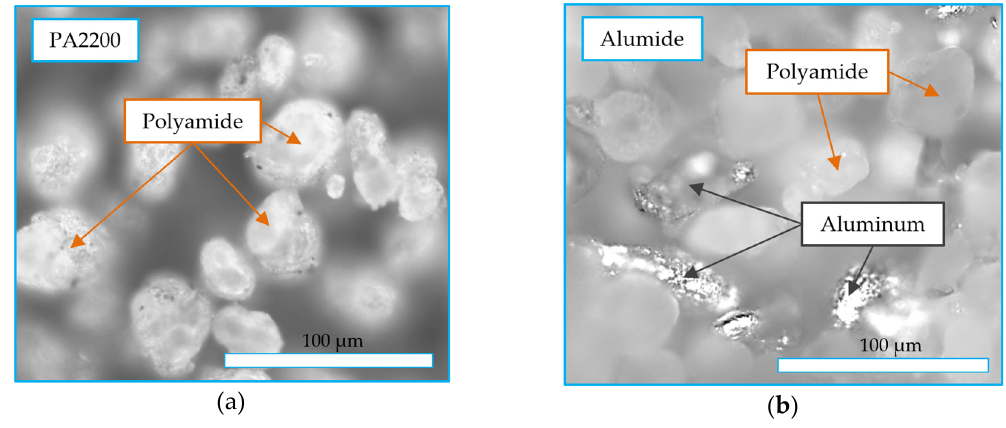
Figure 9. Structure of polyamide ( a ) and Alumide ( b ) samples.